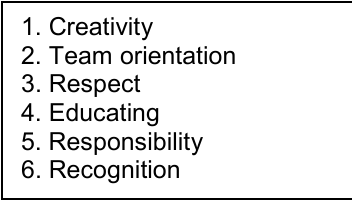
Figure 1 – Key attributes of leaders Рис . 1 – Ключевые качества